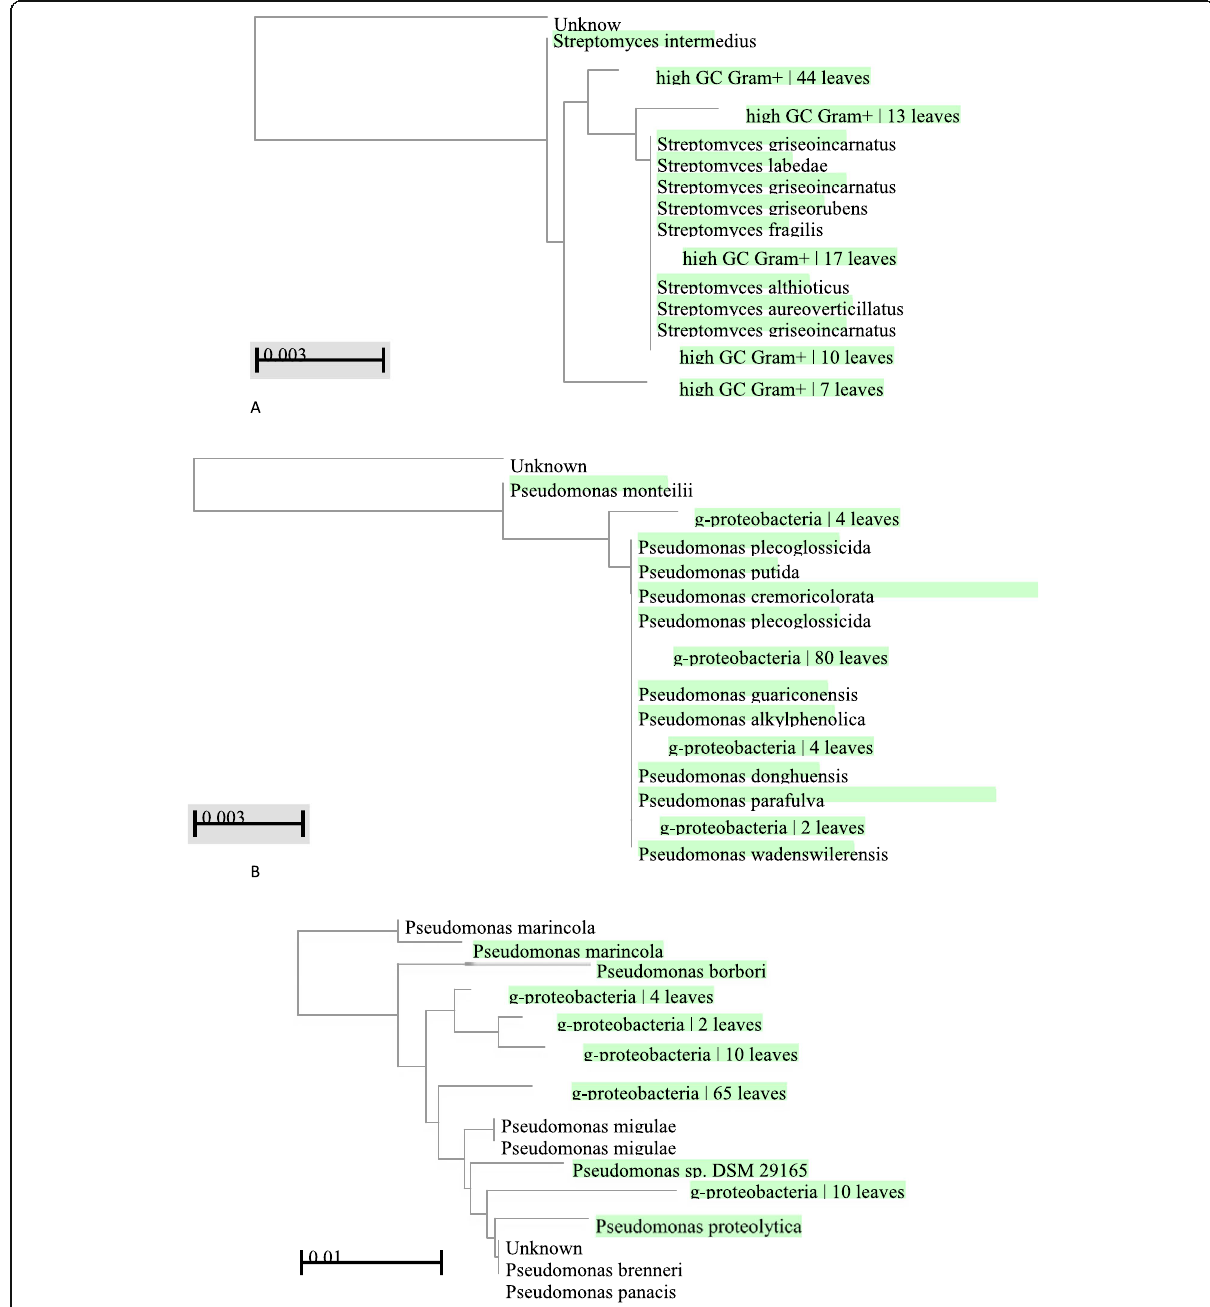
Fig. 1 a An actinomycetes antagonist recovered from corn rhizosphere at a rate of 1% relative to total culturable microbial community (99% identical with to Streptomyces intermedius ). b A bacterial antagonist recovered from potato soil intercropped with cabbage at rate of 0.6% relative to total culturable microbial community (96% identical with to Pseudomonas monteilii ). c A bacterial antagonist recovered from Onion soil at rate of 0.7% relative to total culturable microbial community (100% identical with P. fluorescens